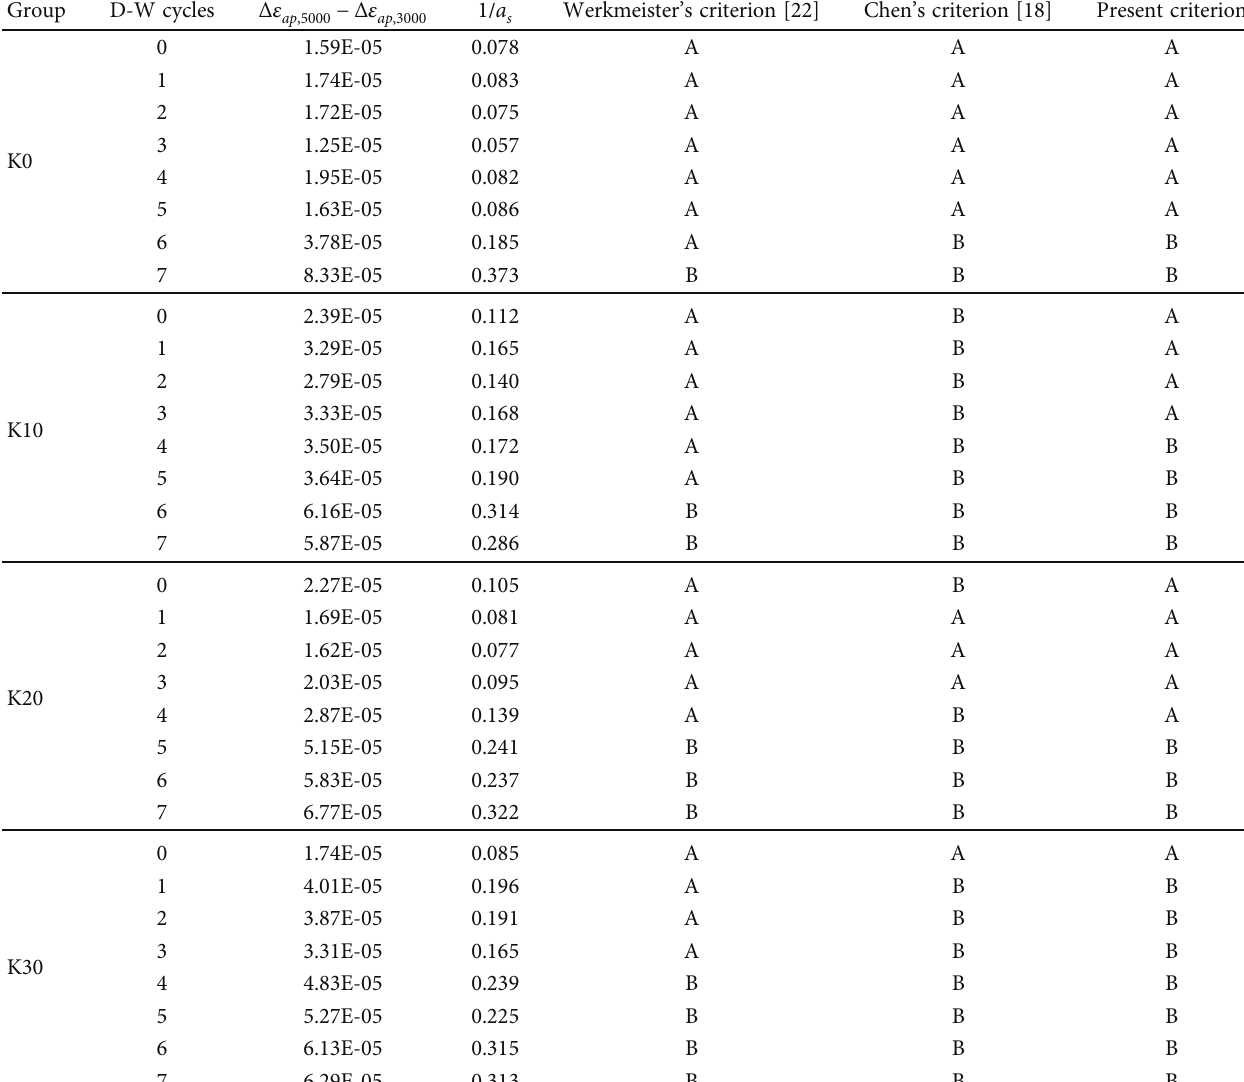
Table 3: The grading results of GRS according to various